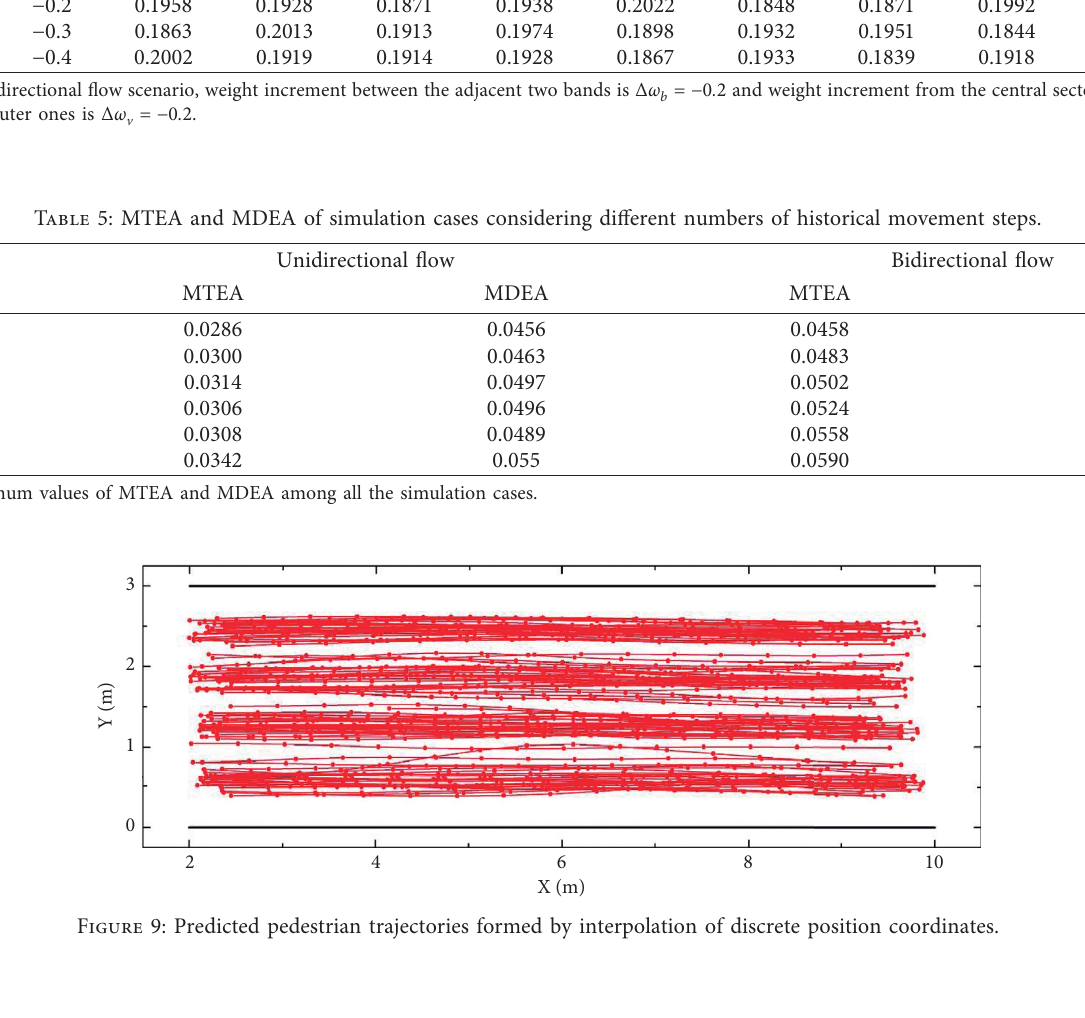
Table 4: MTE and MDE of simulation cases with varied spatial matrix weights for the unidirectional flow scenario. Δ ω v − 0.1 − 0.1 MTE